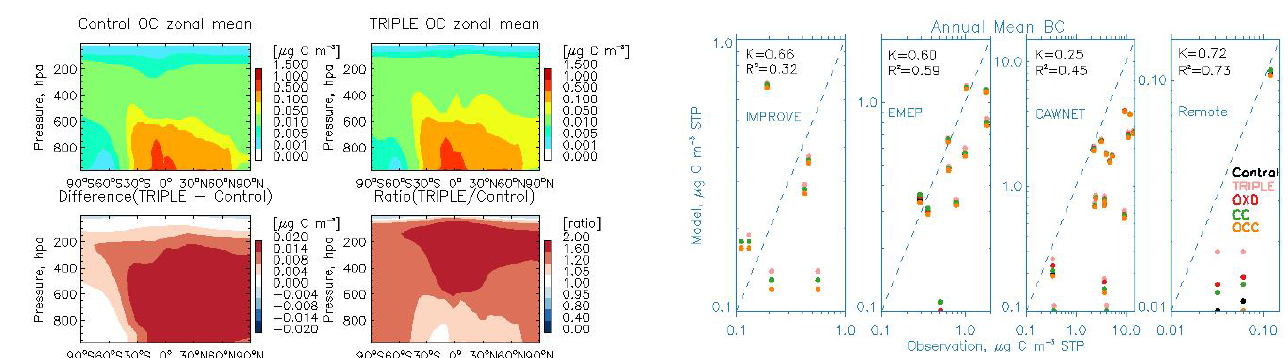
Fig. 7d. Same as Fig. 7b but for zonal mean.